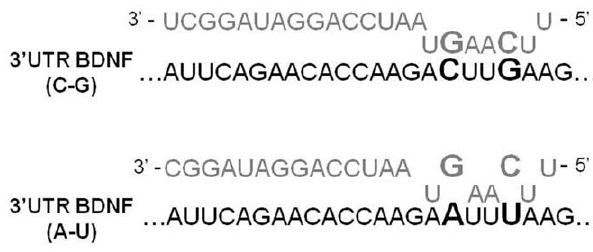
Figure 3. Schematic representation of base pairing between miR-26a sequence and BDNF 3 9 UTR ancestral (C–G) and derivative (A–T) alleles of rs11030100 and rs11030099 poly- morphic sites. MiR-26b has the same seed binding sequence.